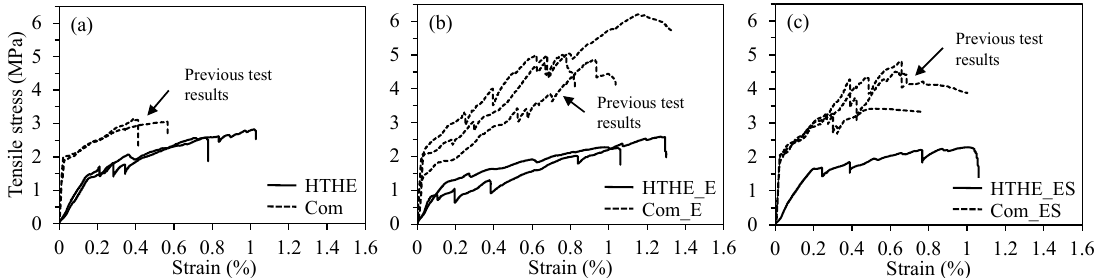
Figure 17. Tensile stress–strain relationship of TRM coupons subjected to the high temperature and humidity environment: ( a ) coupons without surface treatment; ( b ) coupons impregnated by epoxy; ( c ) coupons coated with aluminum oxide powder after epoxy impregnation.